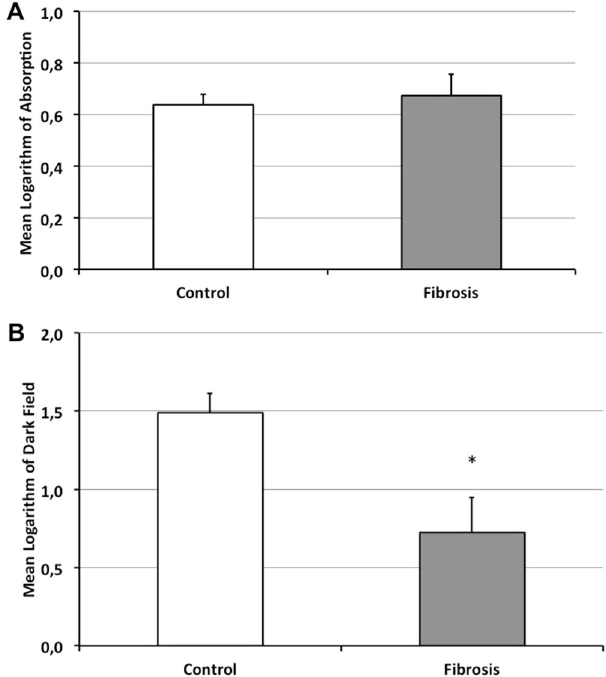
Figure 2. Quantitative evaluation of absorption and dark-field signal intensities. Comparison of absorption signal intensities of healthy control lungs (white column) with fibrotic lungs (grey column) did not show a statistically significant difference ( A ). In the corresponding dark-field images fibrotic lungs showed a significantly decreased dark-field signal intensity compared to healthy lungs; * p < 0.001 ( B ).